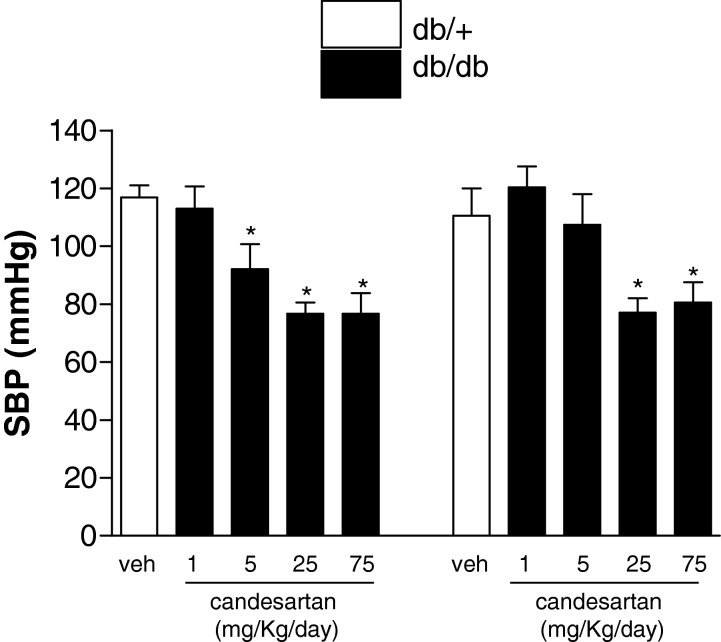
Ultra-high dose of candesartan reduce SBP in db/+ and db/db miceEnd point SBP in db/+ and db/db mice treated with subcutaneous injections of vehicle or candesartan at 1 mg/kg/d, 5 mg/kg/d, 25 mg/kg/d, 75 mg/kg/d for 4 weeks. Results are mean ± S.E.M. of seven mice. *P<0.05, candesartan-treated compared with counterpart vehicle-treated mice.